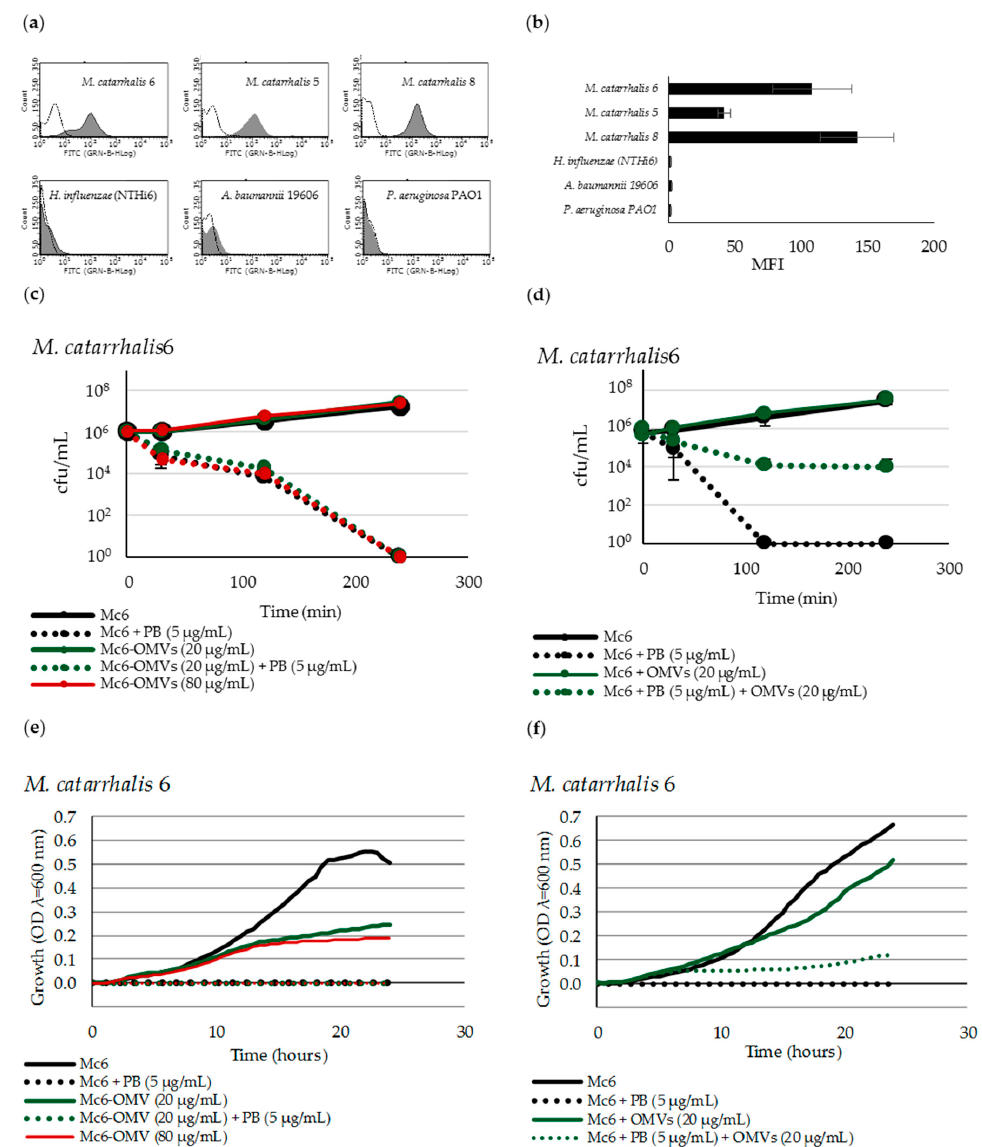
Figure 7. Mc6 OMVs highly associated with bacteria do not protect against polymyxin B-dependent killing. ( a ) Flow cytometry analysis of fluorescein isothiocyanate (FITC)-labelled OMVs associated with intraspecies bacteria (upper panel) and not associated with interspecies bacteria (lower panel), The fluorescence intensities of OMV-associated bacteria are shown as black histograms whereas control bacteria as dotted histograms. Representative plots are shown. ( b ) Quantification of bacteria associated with FITC-labelled OMVs. Data are expressed as mean fluorescent intensity (MFI) ± SD from three independent experiments performed in duplicates. ( c ) Bactericidal activity of polymyxin B against M. catarrhalis after association with OMVs. ( d ) Bactericidal activity of polymyxin B against M. catarrhalis incubated with free OMVs. ( e ) 24 h growth-curve kinetics for M. catarrhalis after association with OMVs. ( f ) 24 h growth-curve kinetics for M. catarrhalis incubated with free OMVs. The kinetics was measured using Varioskan ™ LUX reader with measurements at 30 min intervals. In experiments (c,d) results are shown as mean ± SD from at least two independent experiments. In experiments (e,f) results are shown as mean from at least three independent experiments performed at duplicate and for better readability, SDs were not